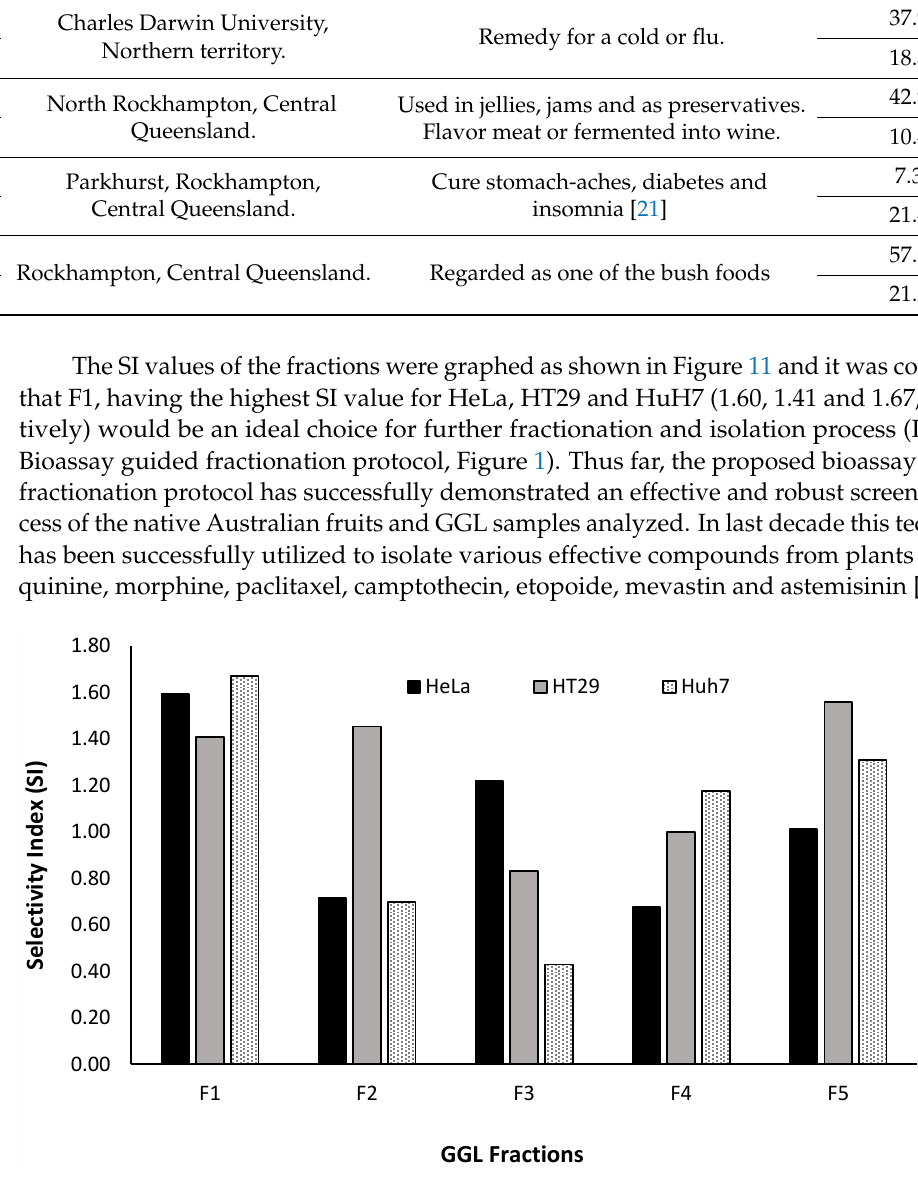
Figure 11. GGL fractions SI values against HeLa, HT29 and Huh7 cell lines. Previously taraxastane-type triterpene saponins and triterpene glycosides, which have also demonstrated antiproliferative activity have been isolated from GGL [32–35]. However, due to the occurrence of several varietals of this plant which yield thousands of complex compounds, there still remains research opportunities. Hence, it is anticipated that further fractionation of GGL F1 may possibly lead to the isolation and purification of lead or novel bioactive